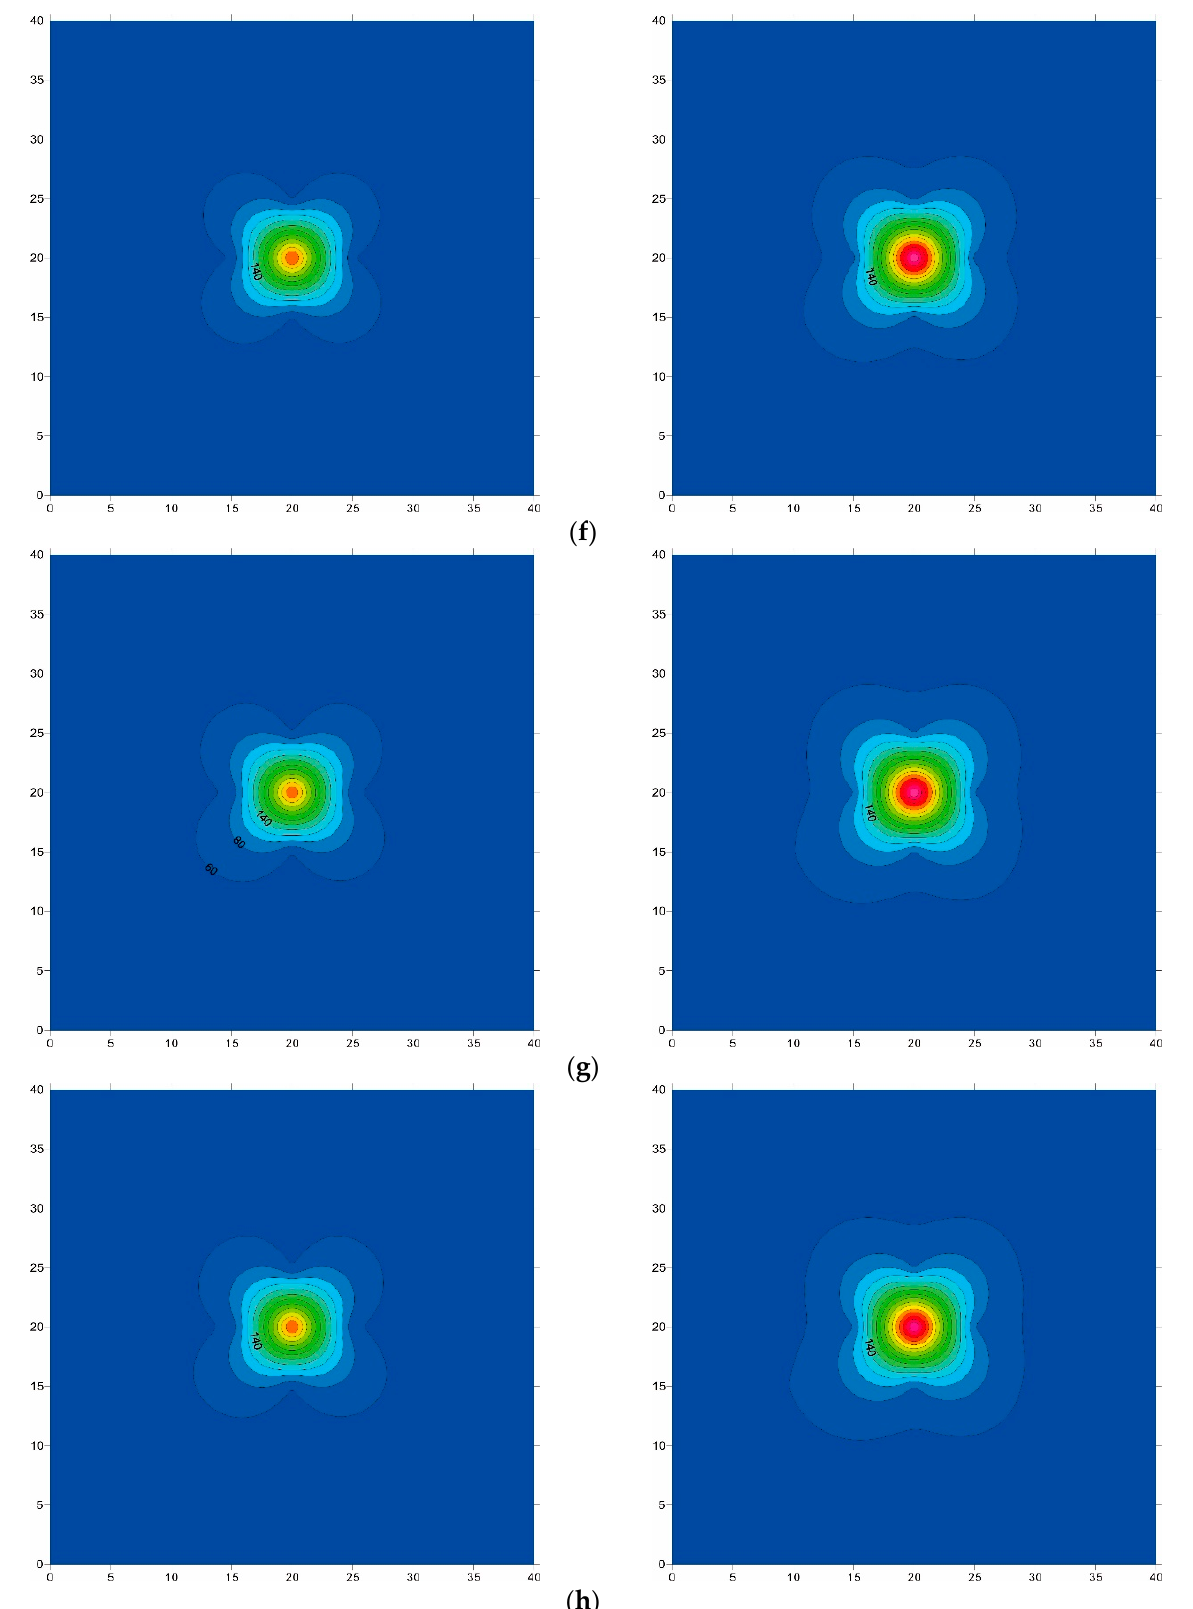
Figure 7. Horizontal temperature profile at the top (right) and middle (left) of the oil layer in each cycle. ( a ) 1st cycle; ( b ) 2nd cycle; ( c ) 3rd cycle; ( d ) 4th cycle; ( e ) 5th cycle; ( f ) 6th cycle; ( g ) 7th cycle; ( h ) 8th cycle.